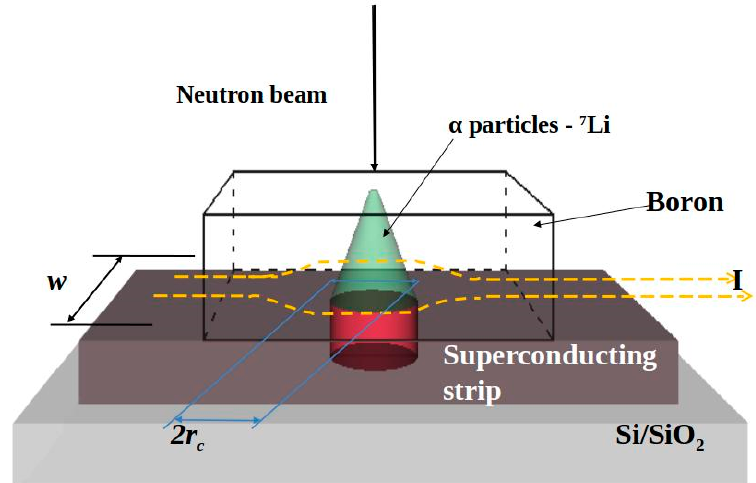
Figure 1. Pictorial view of the hot spot creation in the sc strip. For later convenience, the incoming neutron beam generating α -particles in the B film is also shown. Note, the bias current lines being pushed out of the normal zone to the sides of the strip. To simplify matters, the α -particle is supposed to be emitted in a direction normal to the strip (Adapted from [11], with the permission of AIP Publishing).